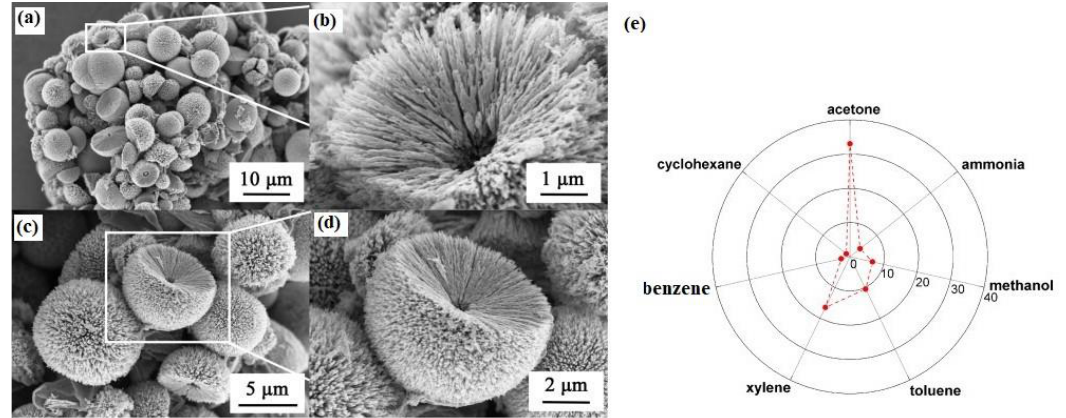
Figure 4. ( a – d ) Scanning electron microscopy images of hierarchical ZnO spheres. ( e ) Selectivity graph of ZnO spheres gas sensor at 230 °C [90]. Reprint permission was obtained from Elsevier.